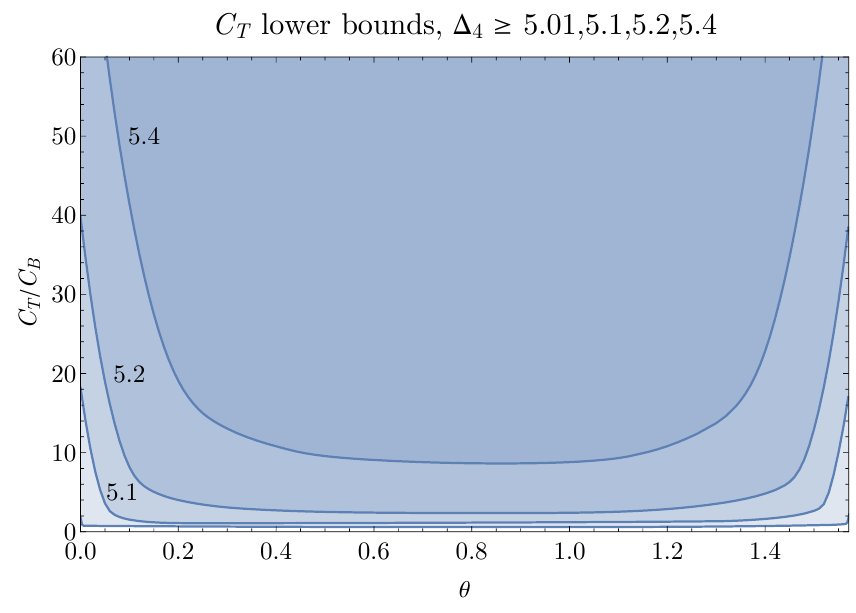
Figure 13 . Lower bounds on C T as a function of (cid:18) for spin-4 gaps (cid:1) 4 (cid:21) 5 : 01 ; 5 : 1 ; 5 : 2 ; 5 :